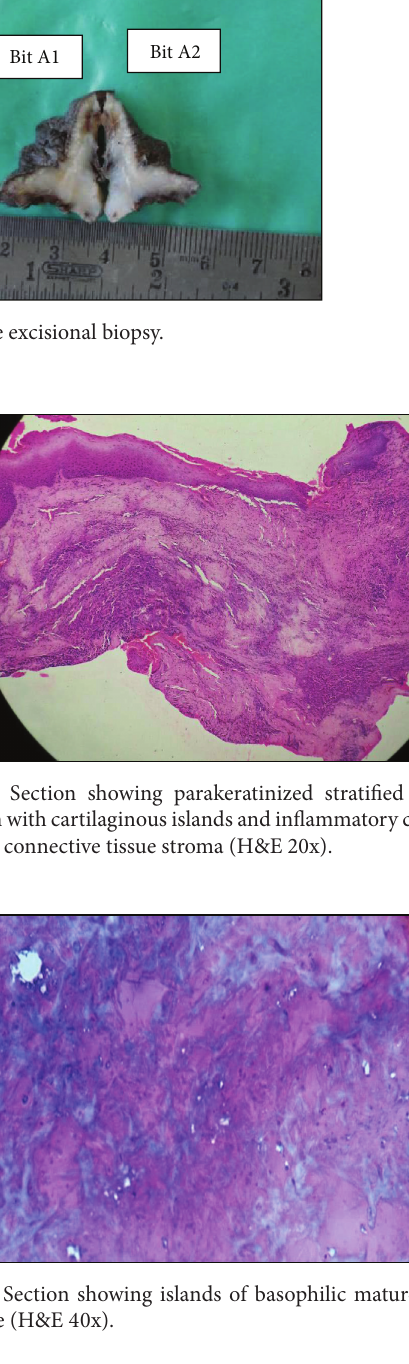
Figure 6: Clinical photograph of post-op extraoral choristoma.